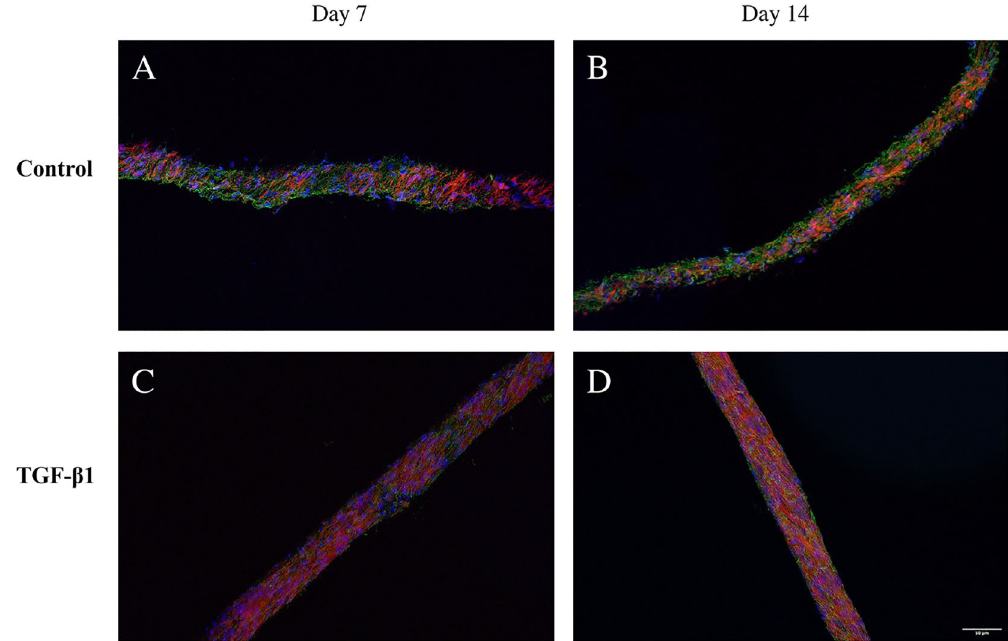
Figure 9. Fluorescence microscopy images of cryosectioned 3D mono-cultures of HDFs incubated in the absence or presence of TGF-β1. The HDF 3D cultures were incubated in the absence (control) or presence of TGF-β1 (5 ng/ml). After 7 and 14 days of incubation, cultures were fixed in 3.7% formaldehyde, stained to visualize actin filaments (red), fibronectin (green), and cell nuclei (blue), followed by cryosectioning, and fluorescence microscopy. All images are representative of 3 independent experiments. Scale bar is 50 μm.